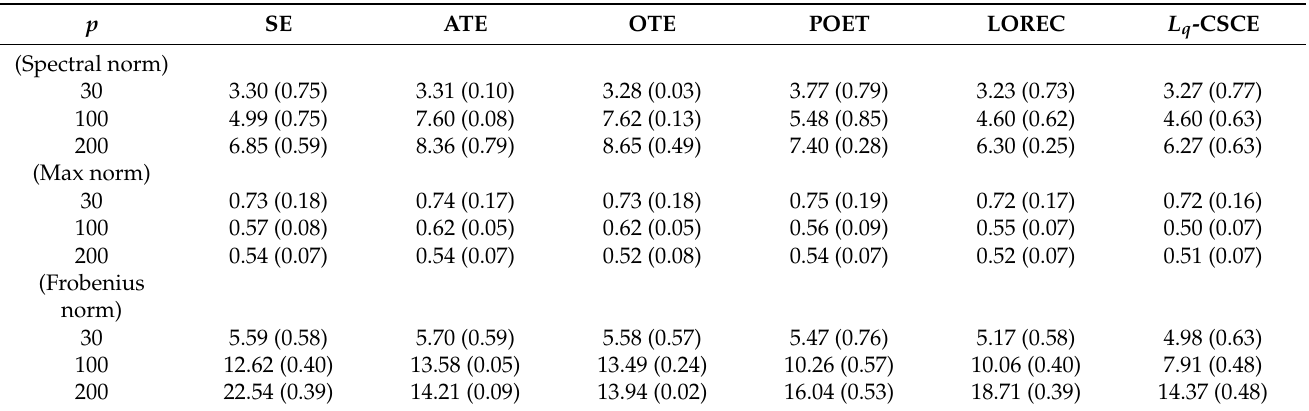
Table 2. Simulation results for Model 2 over 100 replications. The standard errors are given in parentheses.